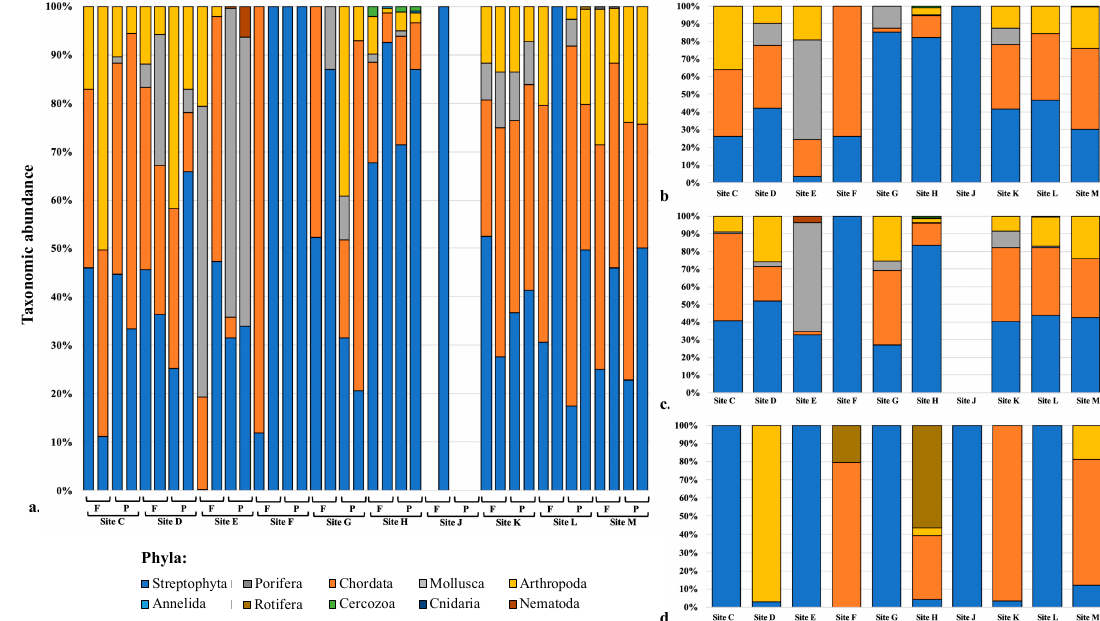
Figure 3 . Relative abundance of 10 phyla recovered from samples collected from 10 sites across Virginia, USA. ( a ) Comparison between duplicate samples prepared with 250 mg of bulk soil (full—F) or 100 mg of bulk soil (partial—P). ( b ) Sum for samples prepared in duplicate with 250 mg of bulk soil. ( c ) Sum for samples prepared in duplicate with 100 mg of bulk soil. ( d ) Singularly from pooled individual plant and insect fragments.